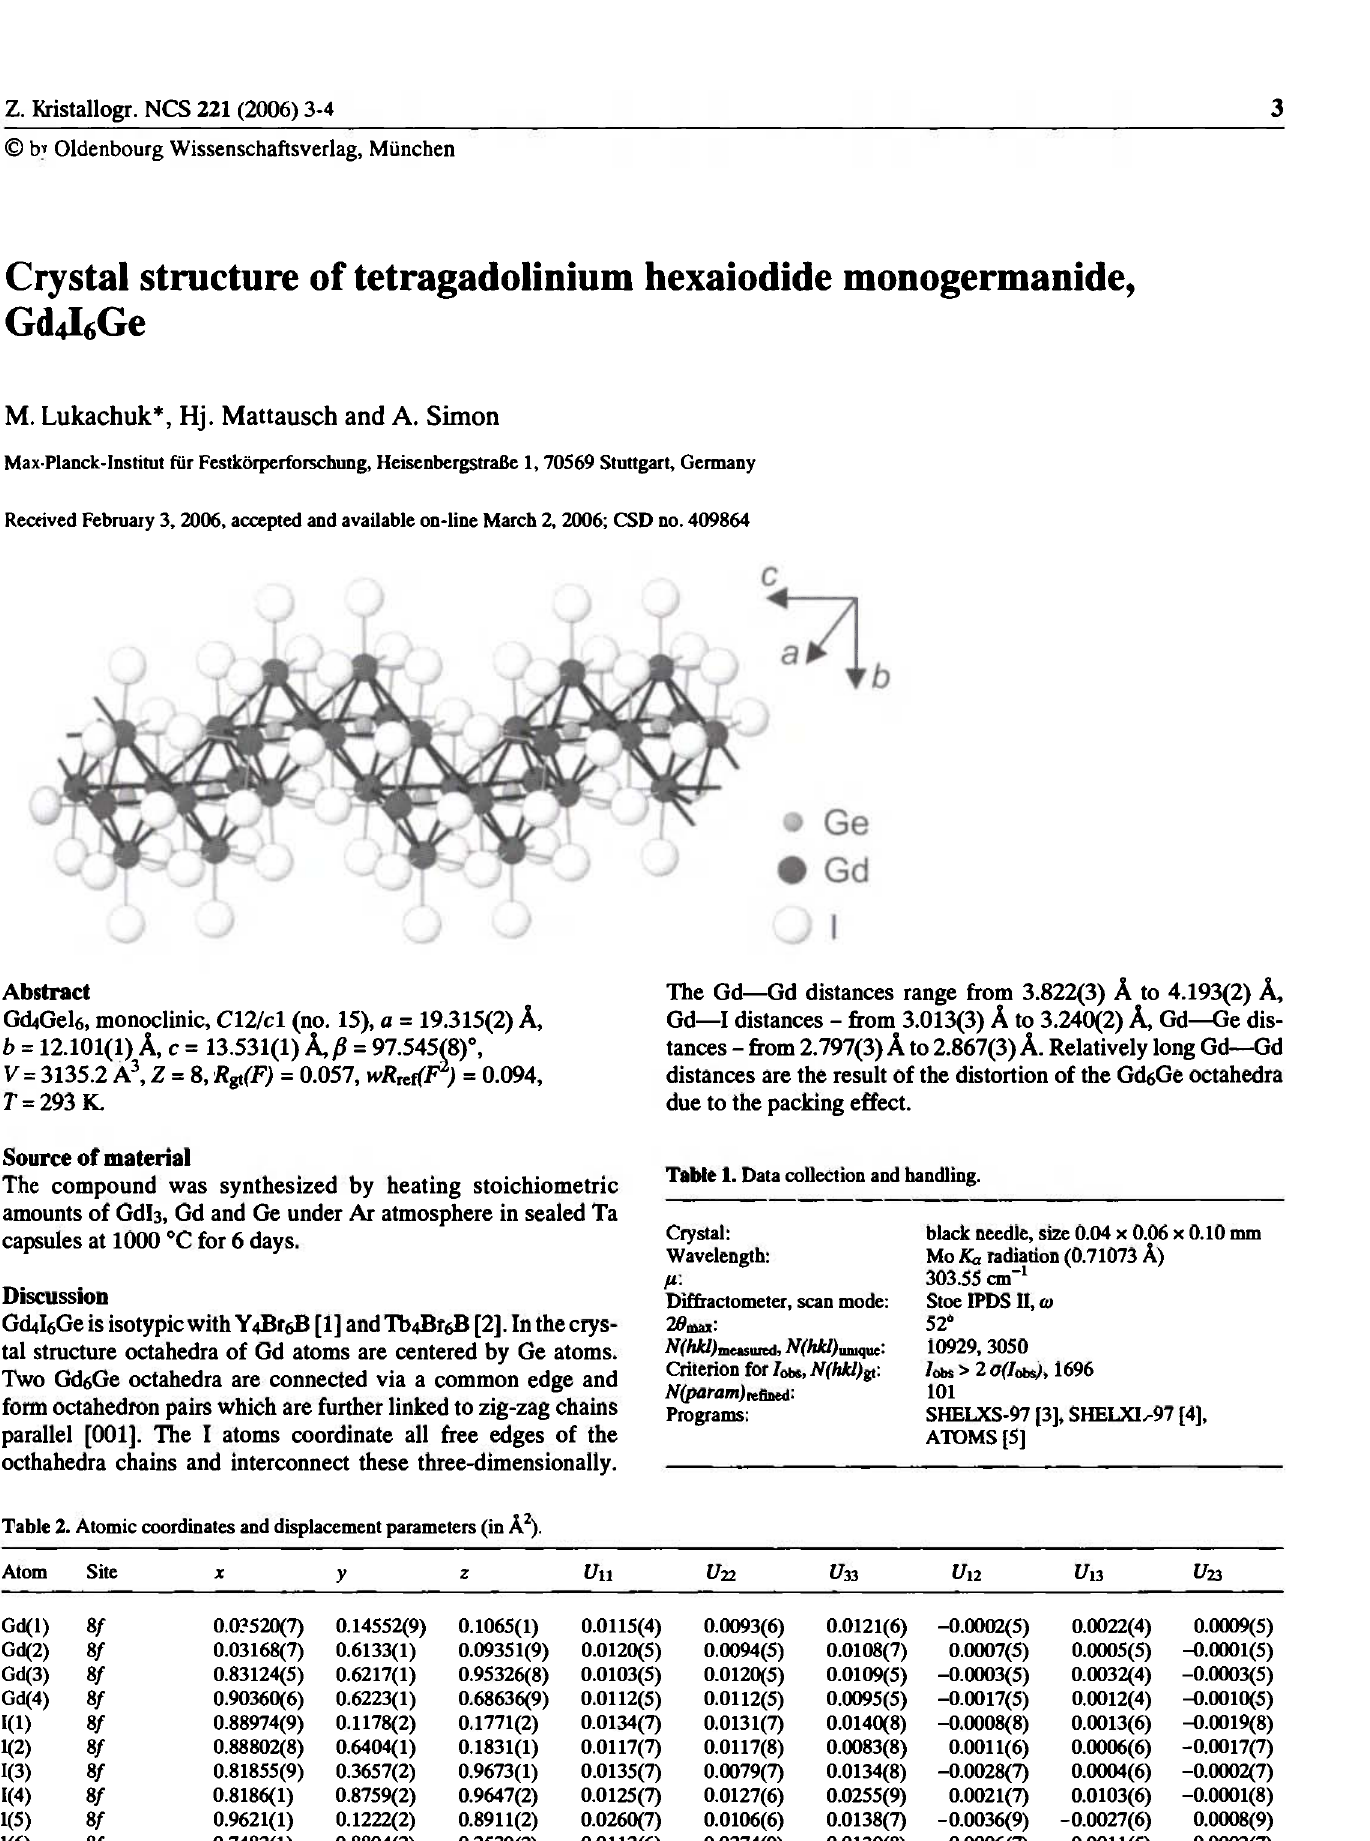
Table 2. Atomic coordinates and displacement parameters (in A 2